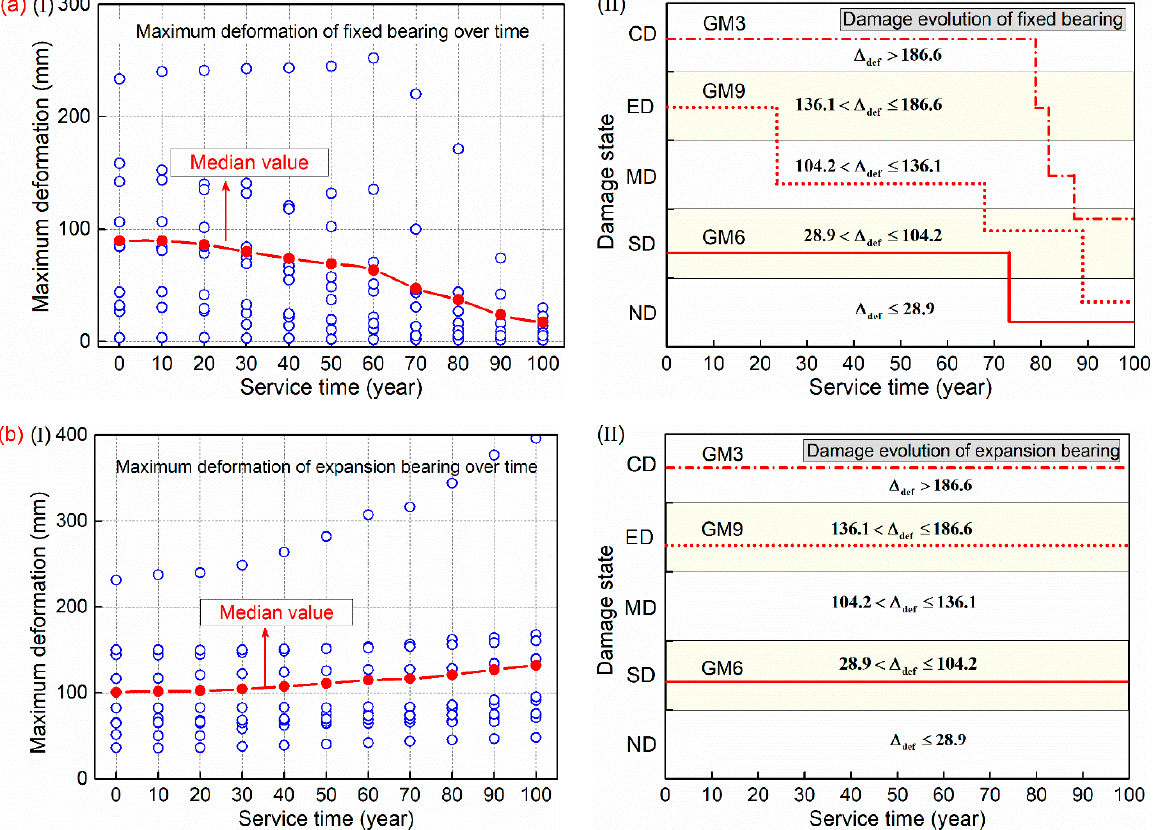
Figure 20. Maximum deformation and damage state over time: ( a ) fixed bearing; ( b ) expansion bearing.